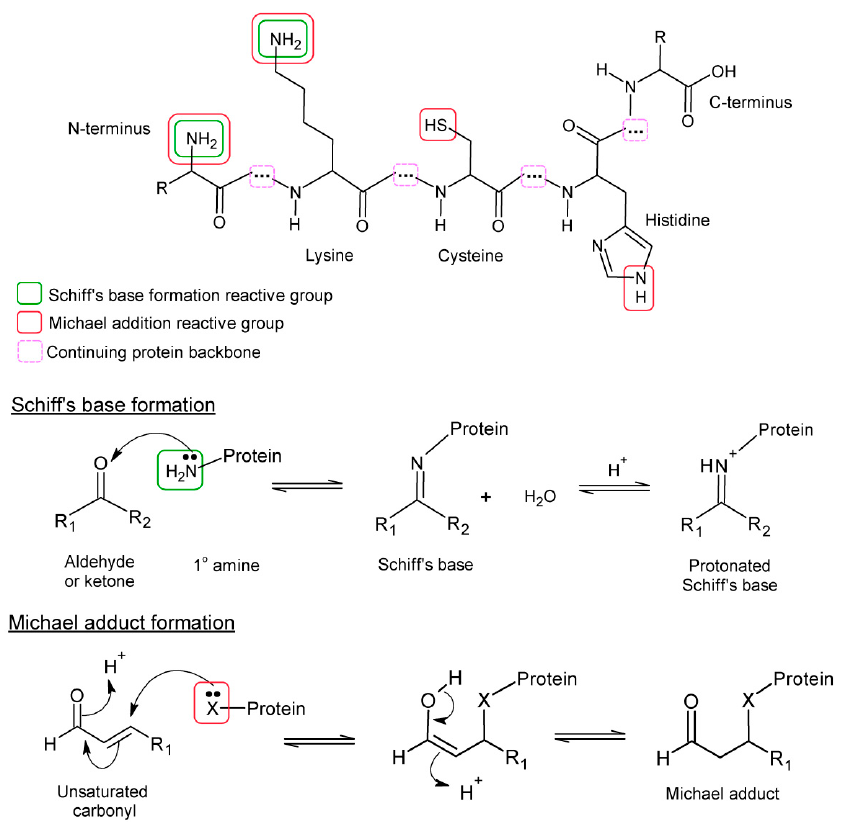
Figure 1. Formation of Schiff’s base and Michael adducts with protein residues. The structures of the lysine, cysteine and histidine residues are shown at the top, with the moieties involved in nucleophilic attack indicated. The histidine imidazole ring exists in 2 resonance forms where the hydrogen can reside on either nitrogen, so either nitrogen can undertake nucleophilic attack. Schiff’s base formation with an amino group is shown in the centre. The Schiff’s base reactions are reversible, involving a hydrolysis reaction. The bottom panel shows Michael adduct formation by nucleophilic group X, where X represents a primary or secondary amine or a thiol. Michael adducts can also decompose by reversal of these reactions, although they are more stable than Schiff’s bases.